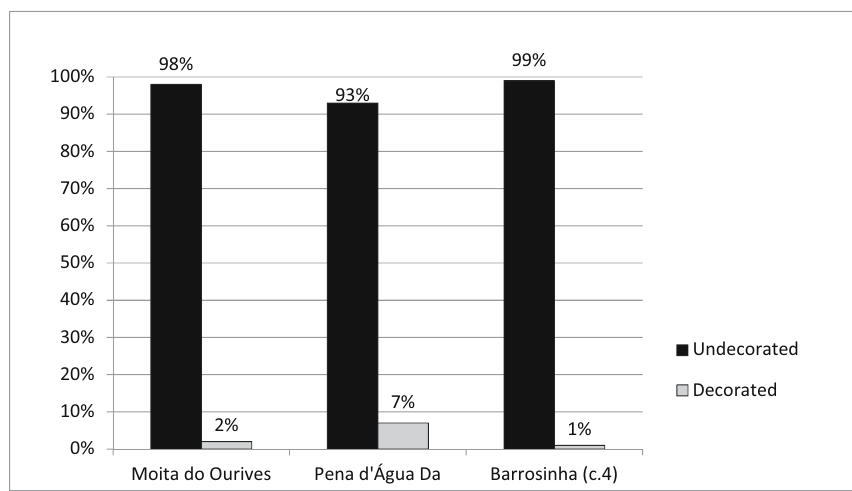
Figure 10: Full Moment of the Middle Neolithic ( ∼ 3700 – 3300 cal BC ) : undecorated versus decorated pottery ( according to: Carvalho, 2016; Neves, 2018; Soares & Silva, 2013 )